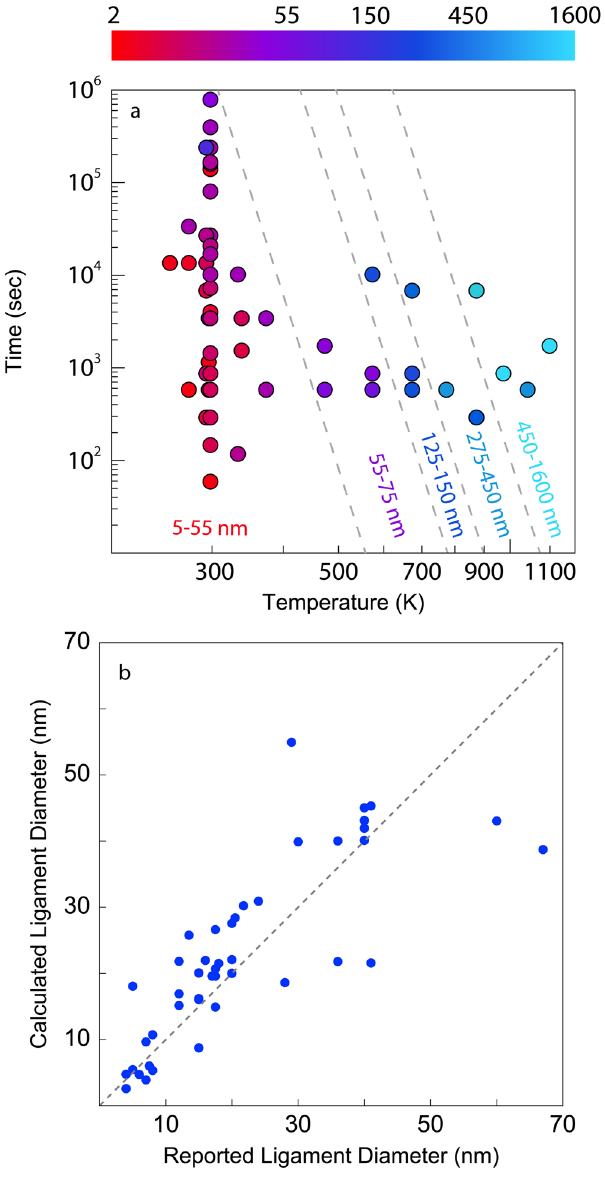
Figure 2. Assessment of data mined from the literature. ( a ) Map of processing conditions. Data points are color coded by the ligament diameter, ranging from red for 2.6 ± 1.3 nm to light blue for 1630 ± 770 nm. The dashed lines are approximate isocontours of the ligament diameter. ( b ) Calculated ligament diameters plotted against reported ligament diameters. The plot excludes six data points – with reported ligament diameters of 100, 140, 200, 480, 589, and 940 nm – to clearly compare data in the 2–70 nm